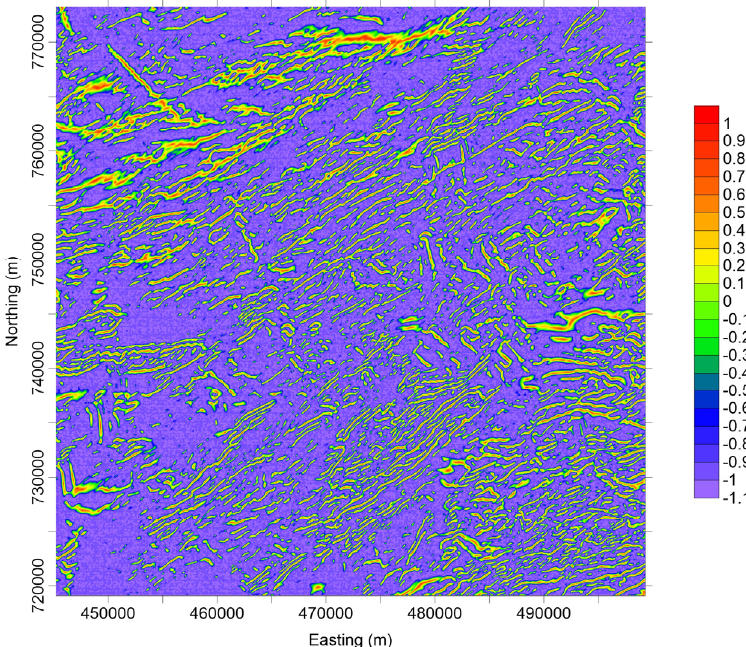
Figure 4. TAHG map of the study area.